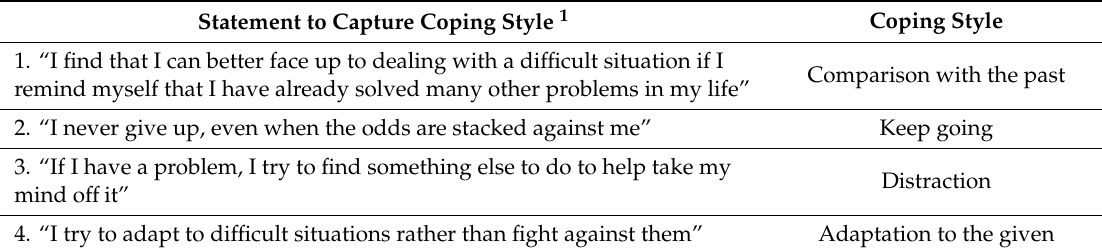
Table A1. The Coping Patterns Schedule